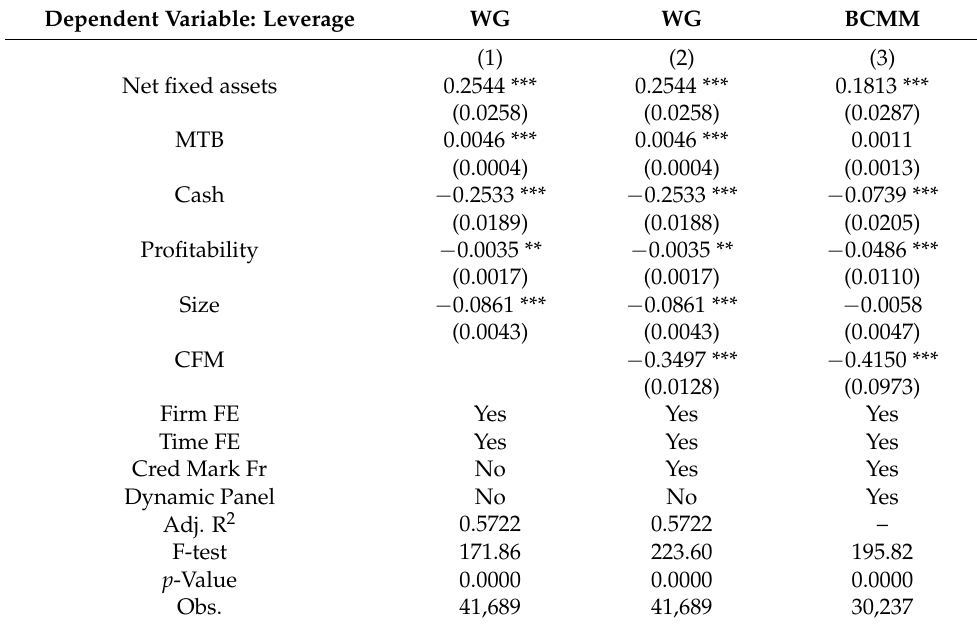
Table 8. Credit Market Freedom and Corporate